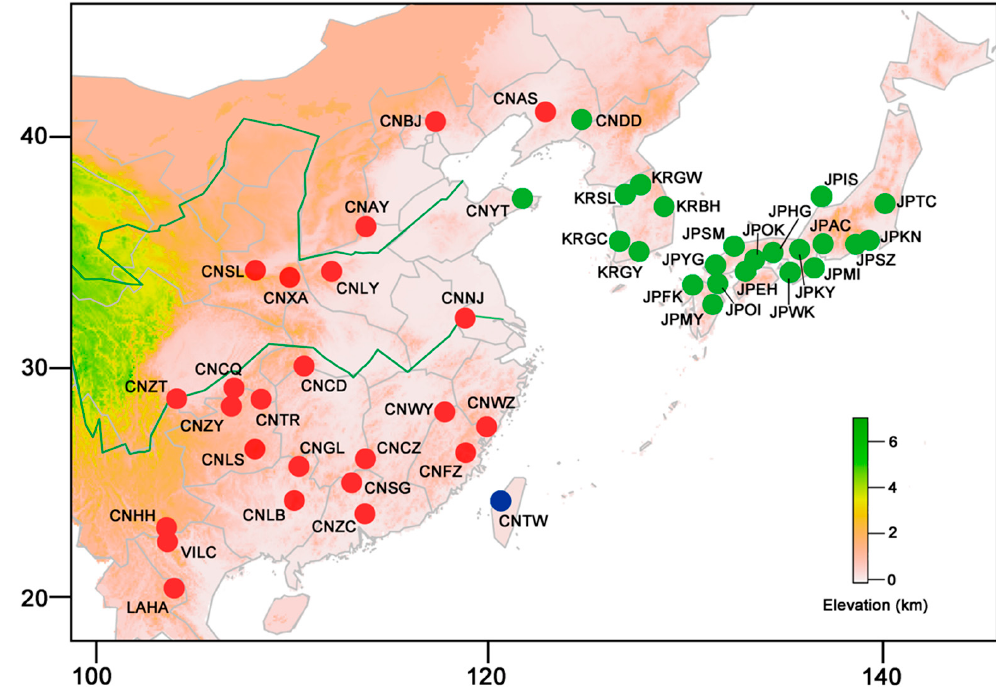
Figure 1. Sample locations of populations used in the present study and spatial population clustering based on the concatenated mitochondrial dataset. Circles in color indicate three clusters classified by BAPS. Population codes and locality details are listed in Table S1.